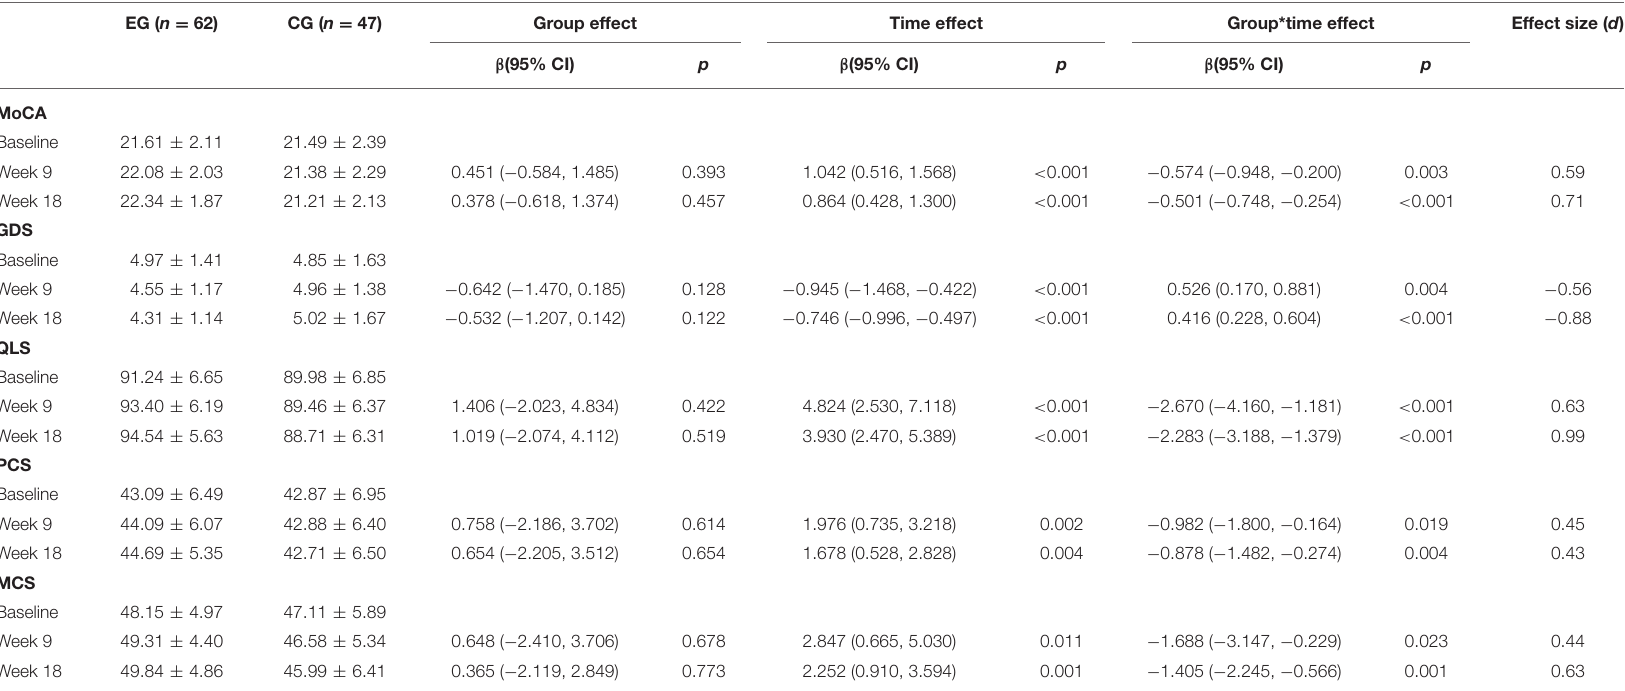
TABLE 2 | Comparison of the experimental and control groups across